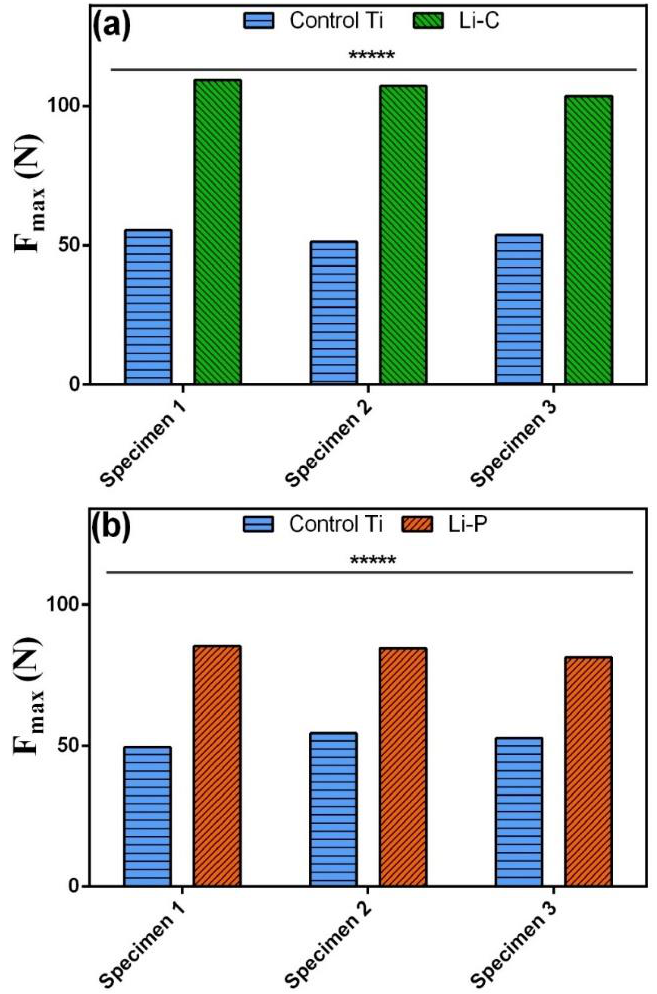
Figure 5. Detachment force, F max , of implants (n = 3) under tensile pull-out testing, inferred in the case of control 3D Ti implants (marked in blue color) and of those functionalized with ( a ) Li-C (marked in green color) and ( b ) Li-P (marked in orange color) coatings, at 9 weeks after surgery. ***** Represents highly significant differences ( p ≤ 0.00001).